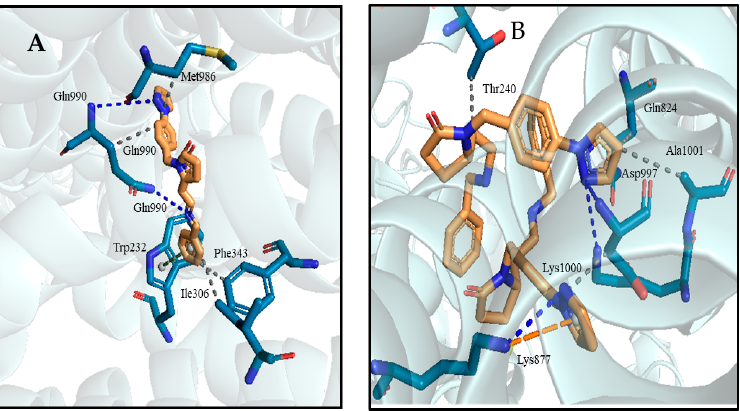
Figure 6. ( A ) Compound ‘A’ and interacting residues are shown in stick form. Hydrophobic interactions (grey dotted line) with Ile306, Phe343, Met986, and Gln990, hydrogen bonding (blue dotted line) with Gln990, and π -stacking (green dotted line) with Trp232. ( B ) The drug–protein interactions of the best docking solution of the two molecules of test compound ‘A’ in the binding pocket of ABCB1. Compound ‘A’ and interacting residues are shown in stick form. Hydrophobic interactions (grey dotted line) with Gln824, Thr240, Ala1001, and Asp997, hydrogen bonding (blue dotted line) with Lys1000 and Asp997, and π -cationic interaction (orange dotted line) with Lys877.